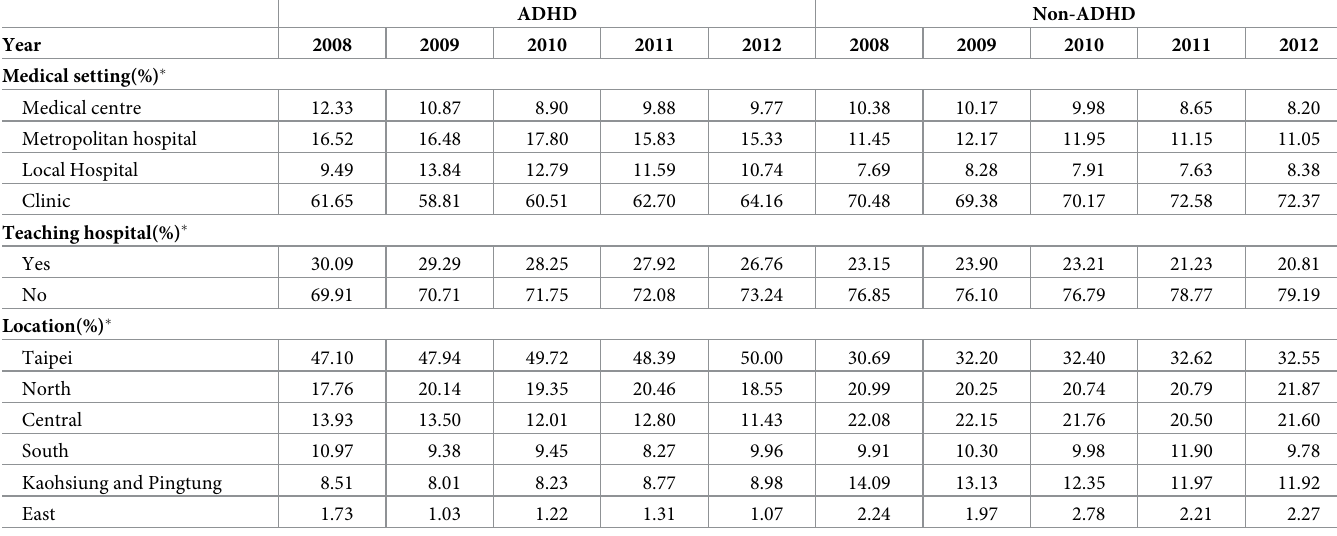
Table 3. Characteristics of rehabilitation resource